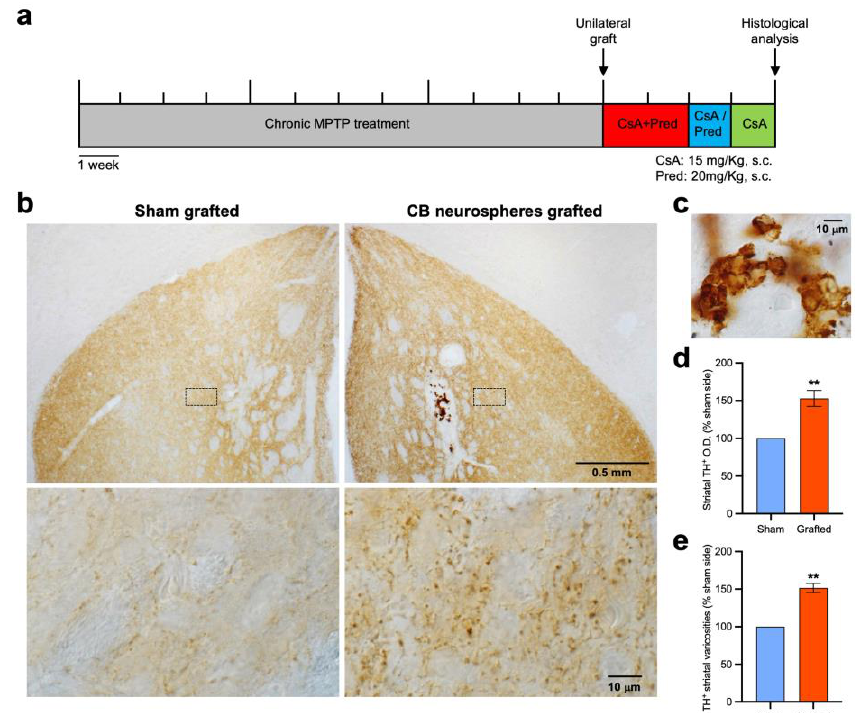
Figure 3. Restorative effects of CB neurospheres xenografts on dopaminergic striatal fibers. ( a ) Scheme of the experimental protocol used to test the reparative effect of in vitro-expanded rat CB cells on mouse dopaminergic striatal terminals. ( b ) Brain coronal sections, after TH immunohistochemistry, of the sham- (left) and CB-neurospheres-grafted (right) striata (upper panels). Insets depicted in lower panels illustrate the repair through axonal sprouting of the dopaminergic striatal terminals induced by the implant. ( c ) Image, at higher magnification and after TH immunostaining, showing the graft of CB stem-cell-derived TH + glomus cells with abundant number of in vitro-expanded dopaminergic glomus cells. ( d ) Analysis of striatal dopaminergic innervation through measurements of TH + optical density (O.D.). ( e ) Stereological quantification of dopaminergic striatal varicosities. In ( d , e ), data are expressed as percentage of sham-grafted side. Paired Wilcoxon test; n = 8; ** p <